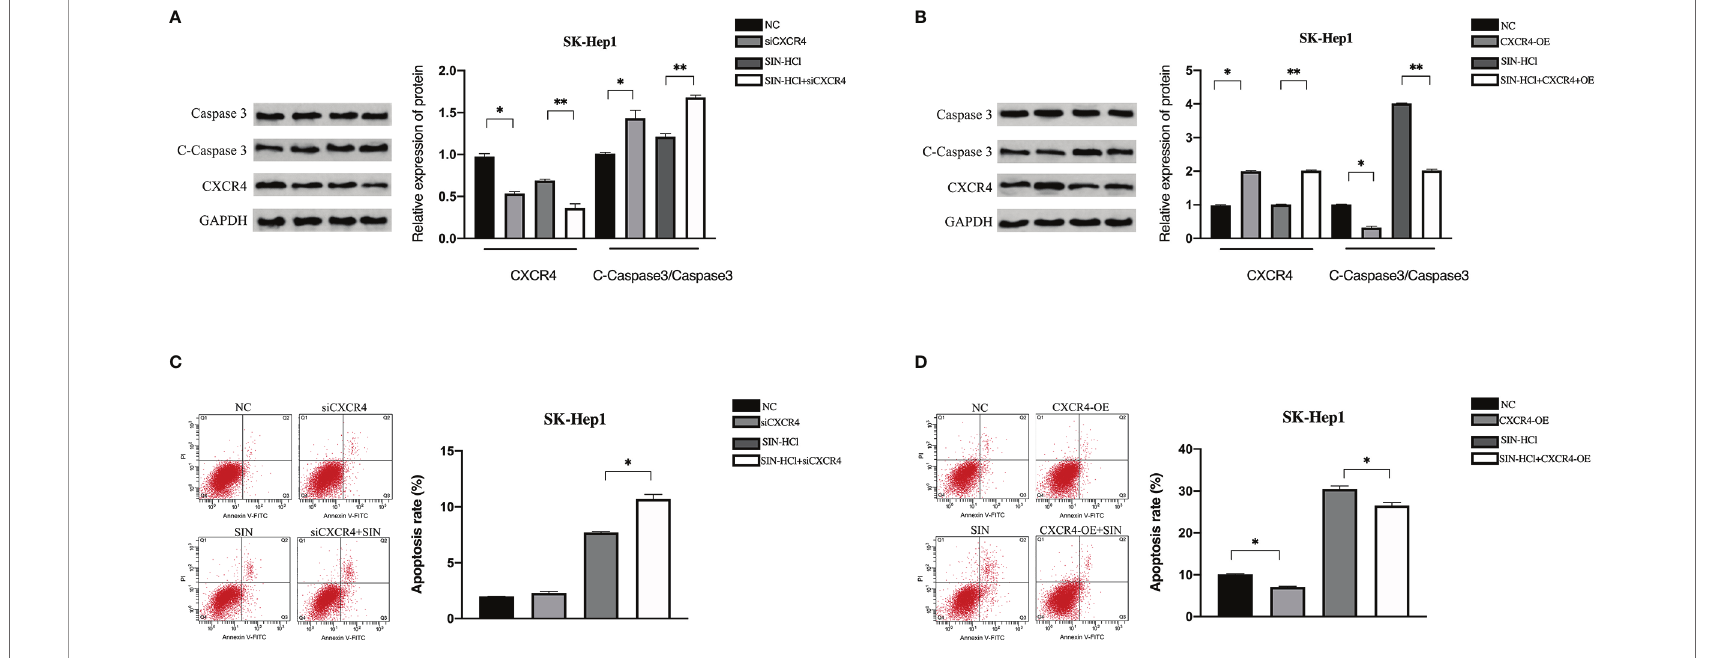
FIGURE 2 | CXCL12-CXCR4 axis was involved in the effect of sinomenine hydrochloride on HCC cell apoptosis. CXCR4 knockdown and overexpression were detected in SK-Hep1 cells. (A, B) WB was utilized to identify the expression of apoptotic protein in SK-Hep1 cells. (C, D) Programmed cell death was identi fi ed via fl ow cell technique. *P < 0.05, **P <